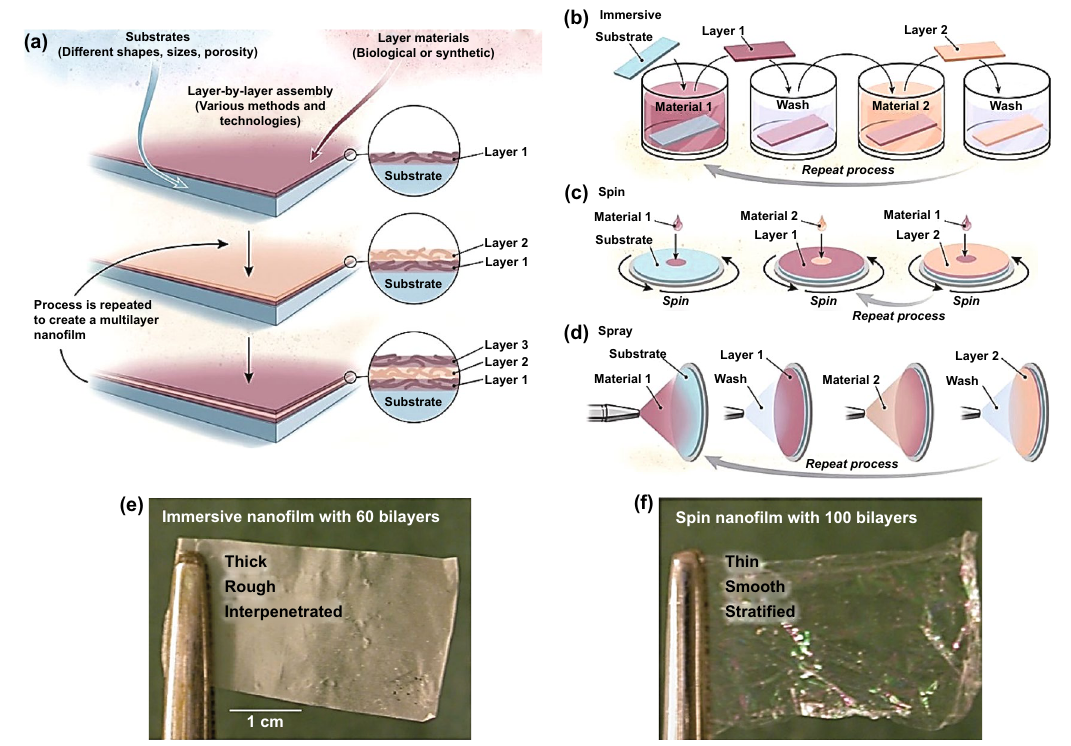
Fig. 14 a Schematics view of multilayer assembly technique. b – d Schematics view of the cyclical process of immersive, spin, and spray assem- bly spray layer by layer assembly. e, f Immersive and spin assembled films of hydrophobically modified poly(ethylene oxide) and poly(acrylic acid). Reproduced with permission from Ref. [41] Copyright © 2015, American Association for the Advancement of